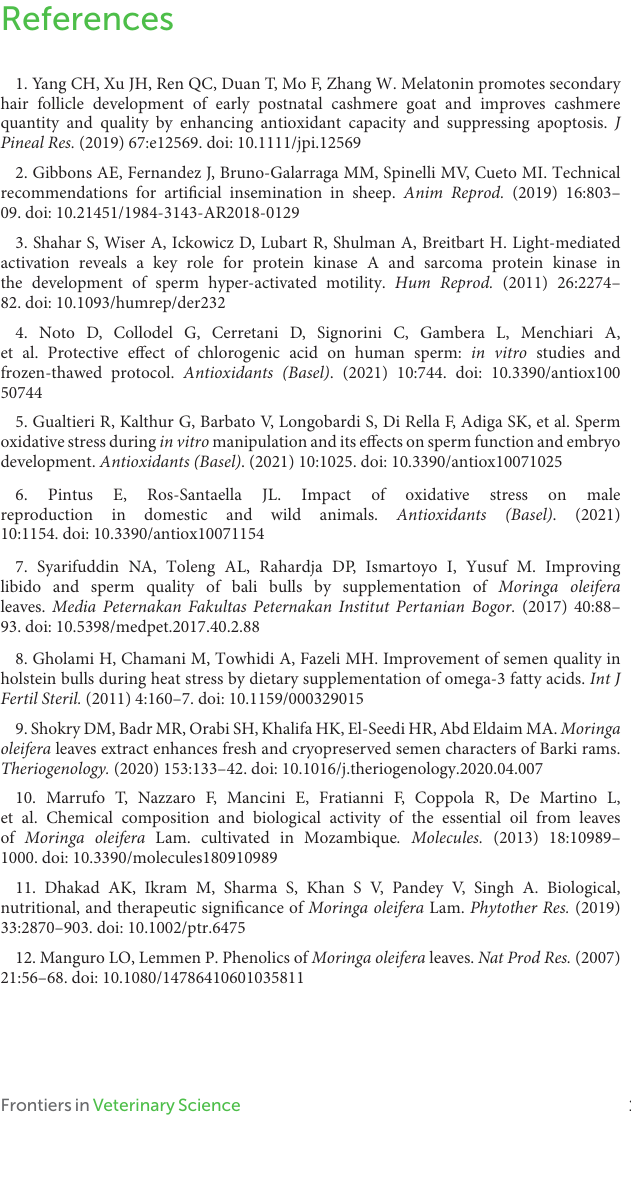
SUPPLEMENTARYTABLE3 Sample sequencing data statistics. SUPPLEMENTARYTABLE4 1006 Metabolites information overview table. SUPPLEMENTARYTABLE5 Differential rumen metabolites between MOLE and CON groups. SUPPLEMENTARYTABLE6 Differential rumen metabolites between MOLP and CON